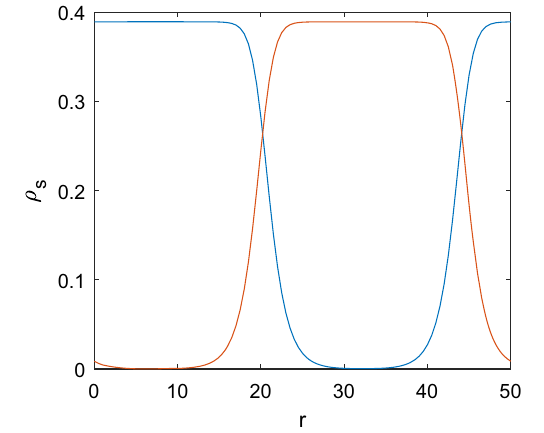
Fig. 6 The profile of ρ s for the phase vortex sheet case η = 0 . 5